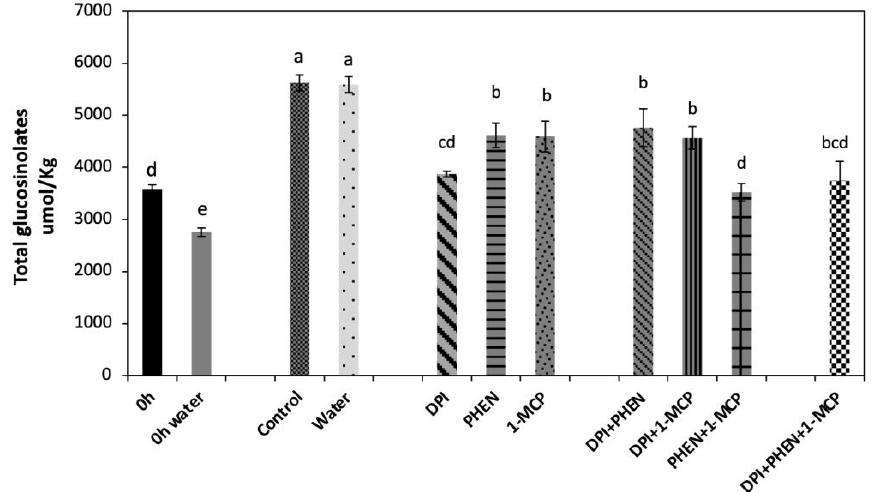
Figure 2. Effect of stress-signaling molecule inhibitors on the wound-induced accumulation of total glucosinolates in broccoli. Glucosinolates were quantified in broccoli chops before and after 21 h of storage. Values represent the mean of three replicates ± standard error of the mean. Concentrations are reported on a dry weight basis. Bars with different letters (a, b, c, d, and e) indicate statistical difference by the LSD test ( p < 0.05). Abbreviations: diphenyleneiodonium chloride (DPI), phenidone (PHEN), and 1-methylcyclopropene.